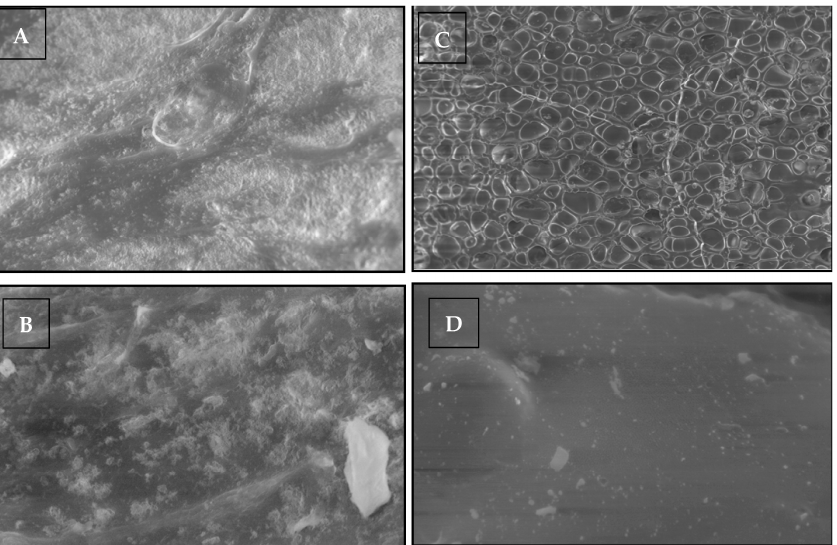
Figure 7. SEM of the essential oil loaded nanoemulgel (EHT = 20.00 Kv, Signal A C2DX, WD 7.5 to 9 mm, resolution ( A ) = 2.01 kx, ( B ) = 5.03 KX, ( C ) = 249 KX, ( D ) = 25 KX).